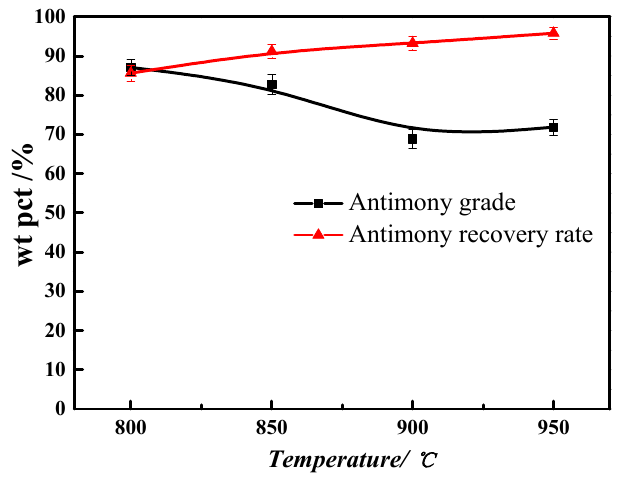
Figure 7. Influence of smelting temperature on the extraction of antimony and antimony grade. ( α salt = 1.0, W NaCl : W salt = 40%, α Fe = 1.0, W coke : W stibnite = 30%, 180 min). 2 O 3